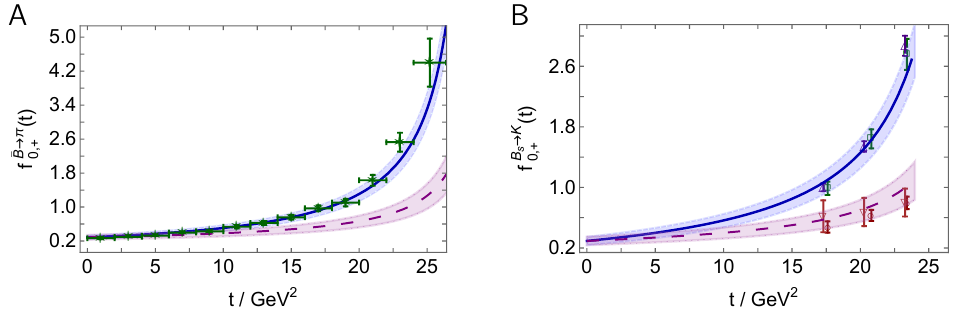
Figure 21. CSM predictions for B ( s ) semileptonic transition form factors: f + —solid blue curve; f 0 —long-dashed purple curve; SPM uncertainty in each—like-coloured shaded bands. Left panel ( A) : ¯ B 0 → π + . Data (green stars): reconstructed from the average [368] (Table 81) of data reported in References[385–388]. Right panel ( B) : ¯ B 0 s → K + . lQCD results: f + —indigo open up-triangles [389] and green open boxes [390]; f 0 —brown open down-triangles [389] and red open circles